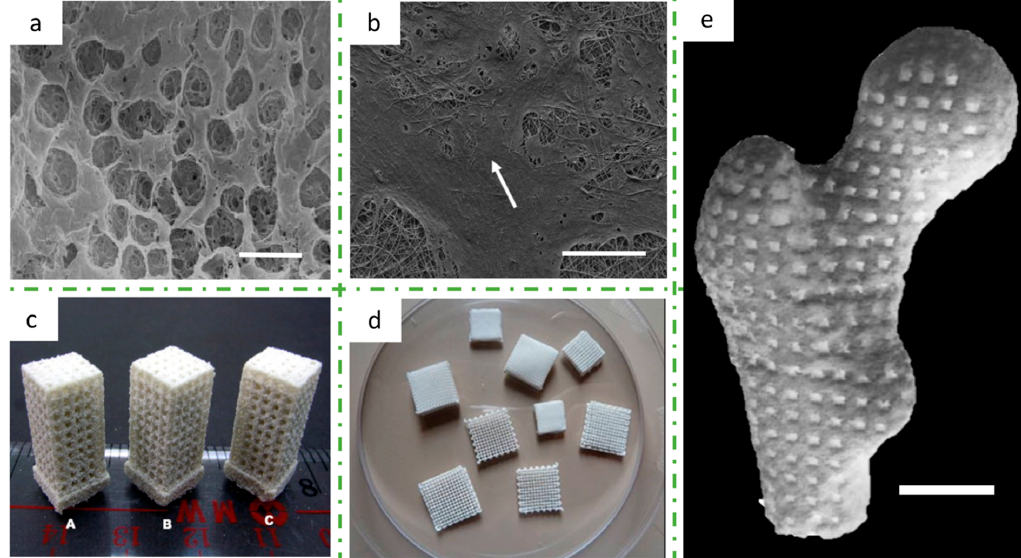
Figure 10. Experimental PHAs applications for bone tissue engineering. ( a ) SEM images of a porous PHBV scaffold obtained by salt leaching (scale bar = 10 µ m; adapted from Reference [144]). ( b ) SEM micrographs of PHBH/silk fibroin (1:1) electrospun films after 14 days of human-umbilical-cord-derived mesenchymal stem cells culture. The white arrow indicates the cells homogeneously distributed on the microporous film (scale bar = 150 μ m; adapted from Reference [92]). ( c ) Visual appearance of Ca-P/PHBV scaffolds loaded with BSA and 3D printed via SLS, using different sintering parameters: (A) laser power = 12.5 W and scan spacing = 0.1 mm; (B) laser power = 15 W and scan spacing = 0.1 mm; (C) laser power = 15 W and scan spacing = 0.15 mm (adapted from Reference [136]). ( d ) Visual appearance of PHBH scaffolds 3D printed by CAWS (adapted from Reference [114]). ( e ) Calcium phosphate (Ca–P)/PHBV nanocomposite 3D printed via SLS for the fabrication of a proximal femoral condyle scaffold (scale bar = 1 cm; adapted from Reference [147]).